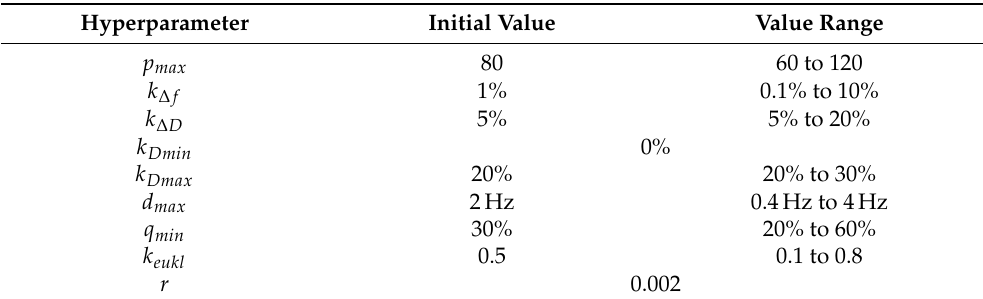
Table 2. Value range and initial values of the hyperparameters used in the optimization stage of the modal parameter optimization for both use cases; a description of the parameters can be found in Table 1 and Section 2.1. The regularization parameter r and the minimum modal damping k Dmin were set constant.